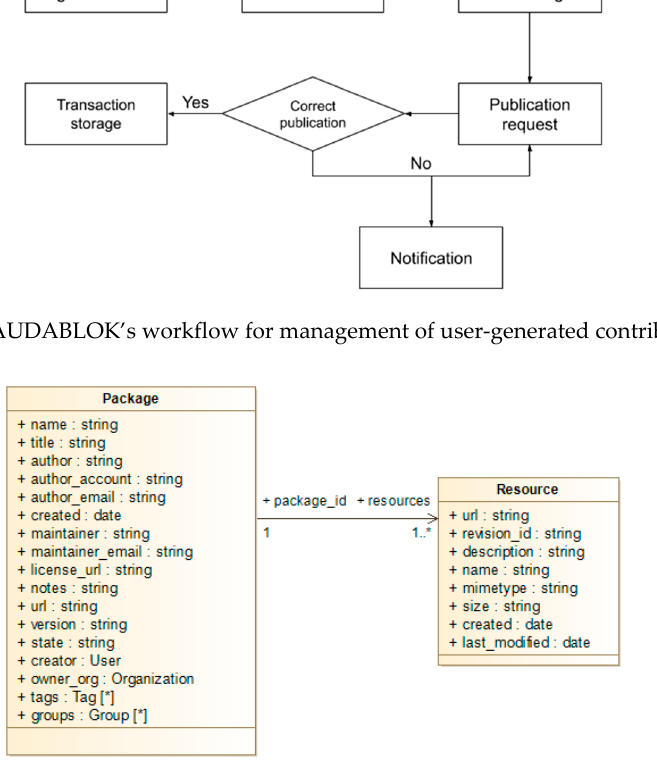
Figure 3. CKAN’s data model for package (dataset) and resource